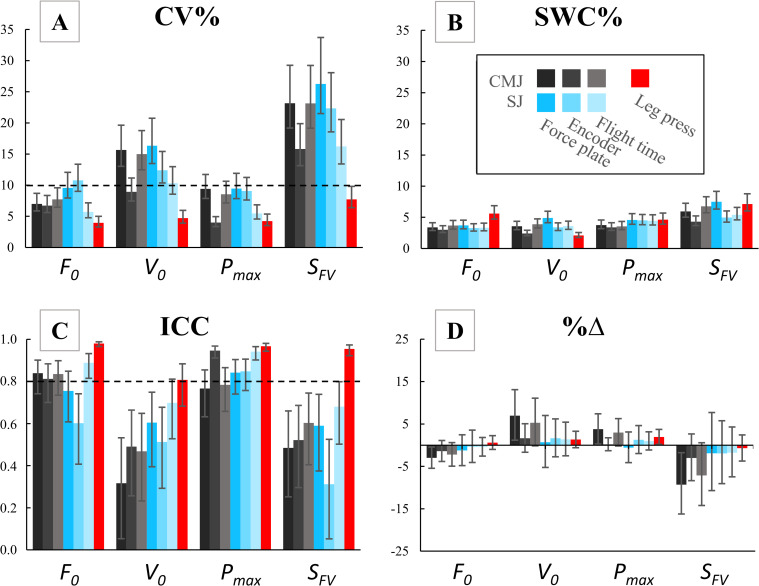
Measures of reliability for the FV variables obtained from main analysis.Panel A- Coefficient of variation (CV%), panel B- Smallest worthwhile change (SWC%), panel C- Interclass correlation coefficient (ICC), panel D- Mean % change (%Δ). All values were obtained by combining test 1–2 (n = 27) and 3–4 (n = 19). Error bars represent 95% confidence intervals. Dotted line represents line of acceptable reliability.